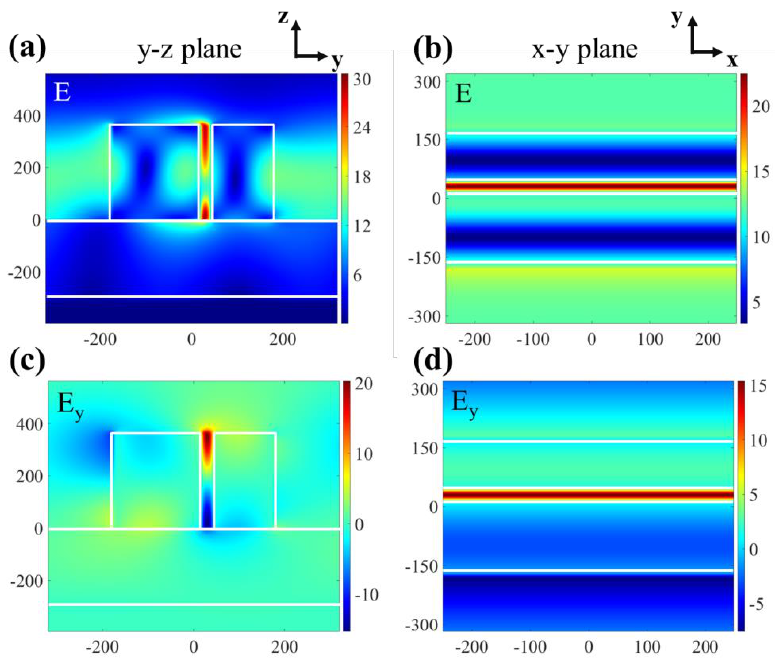
Figure 4. The electric field distribution at the peak of the Fano resonance spectral curve, ( a ) at y-z plane, ( b ) at x-y plane. The electric field in y-direction normalized to the field amplitude of the incident light, ( c ) at y-z plane, ( d ) at x-y plane.